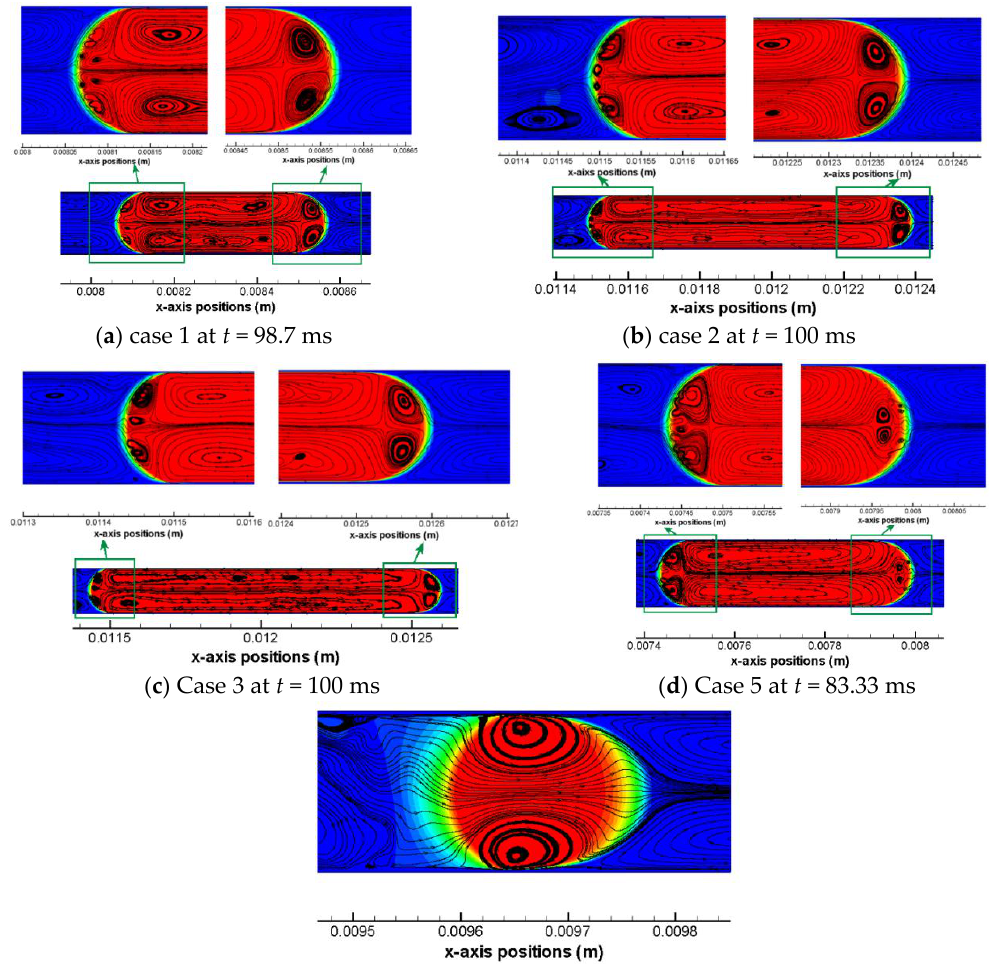
Figure 6. Representative pattern of flow streamlines within the CO 2 drops and at the interface for all the other five cases (other than case 4), i.e., ( a ) Case 1; ( b ) Case 2; ( c ) Case 3; ( d ) Case 5; and ( e ) Case 6.